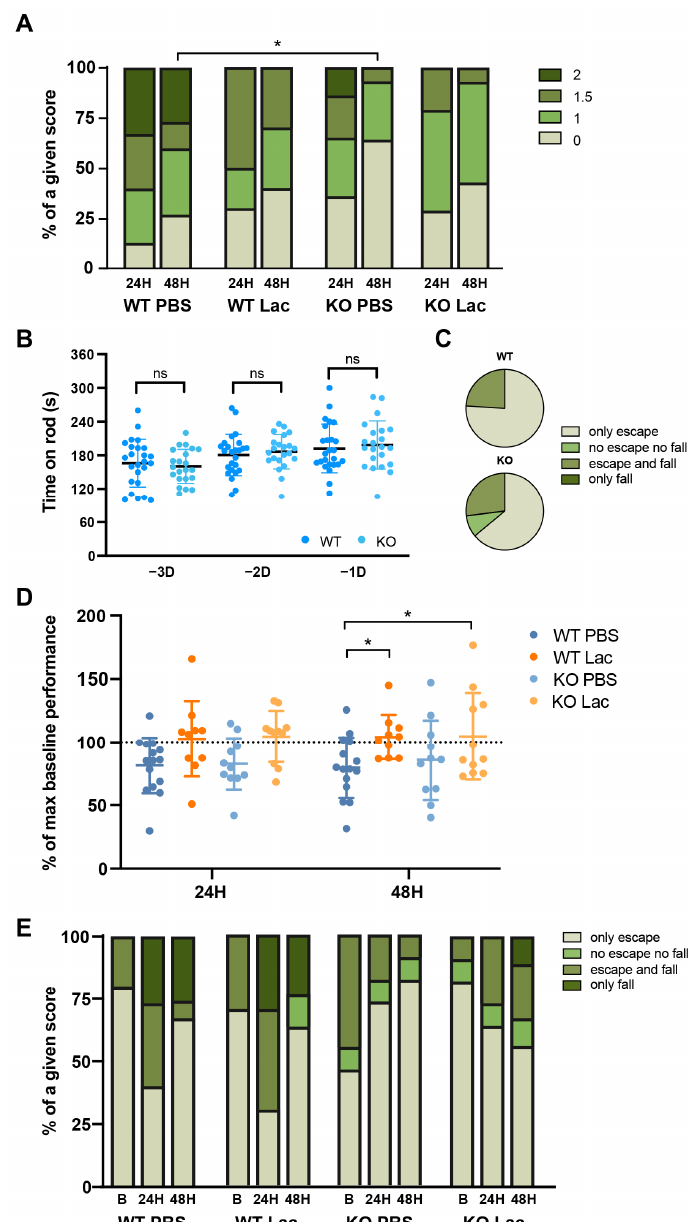
Figure 2. Effect of lactate on post-MCAO behavioral outcome of WT and HCAR1 KO mice. ( A ) Neurological deficit scores (0: no deficit; 1: failure to extend right forepaw; 1.5: intermittent circling; 2: persisting circling) evaluated at 24 h or 48 h after transient MCAO followed by treatment with PBS or lactate (Lac, 1 μmol/g) at reperfusion. Two-way ANOVA with Holm–Sidak’s post hoc test. ( B ) Time spent on the accelerating rod during the three consecutive training days (−3D, −2D, −1D) was similar for WT mice (dark blue) and KO mice (light blue). One-way ANOVA with Holm–Sidak’s post hoc test. ( C ) Wire-hanging test results (from better to worse: only escape; neither escape nor fall; escape and fall; only fall) obtained at baseline for each genotype. In the WT group, 76% of mice only escaped and 24% of mice escaped and fell, whereas in the KO group 64% of mice only escaped, 9% of mice neither escaped nor fell, and 27% of mice escaped and fell. ( D ) Percentage of the maximal performance achieved during the rotarod training of WT and HCAR1 KO mice tested at 24 h and 48 h after the surgery and subsequent treatment. Both WT and KO lactate-treated groups showed an improved performance at 48 h. Two-way ANOVA with Holm–Sidak’s post hoc test. ( E ) Scoring of the performance on the wire-hanging test at baseline ( B ), 24 h or 48 h after MCAO for each experimental condition. Two-way ANOVA with Holm–Sidak’s post hoc test. * p <